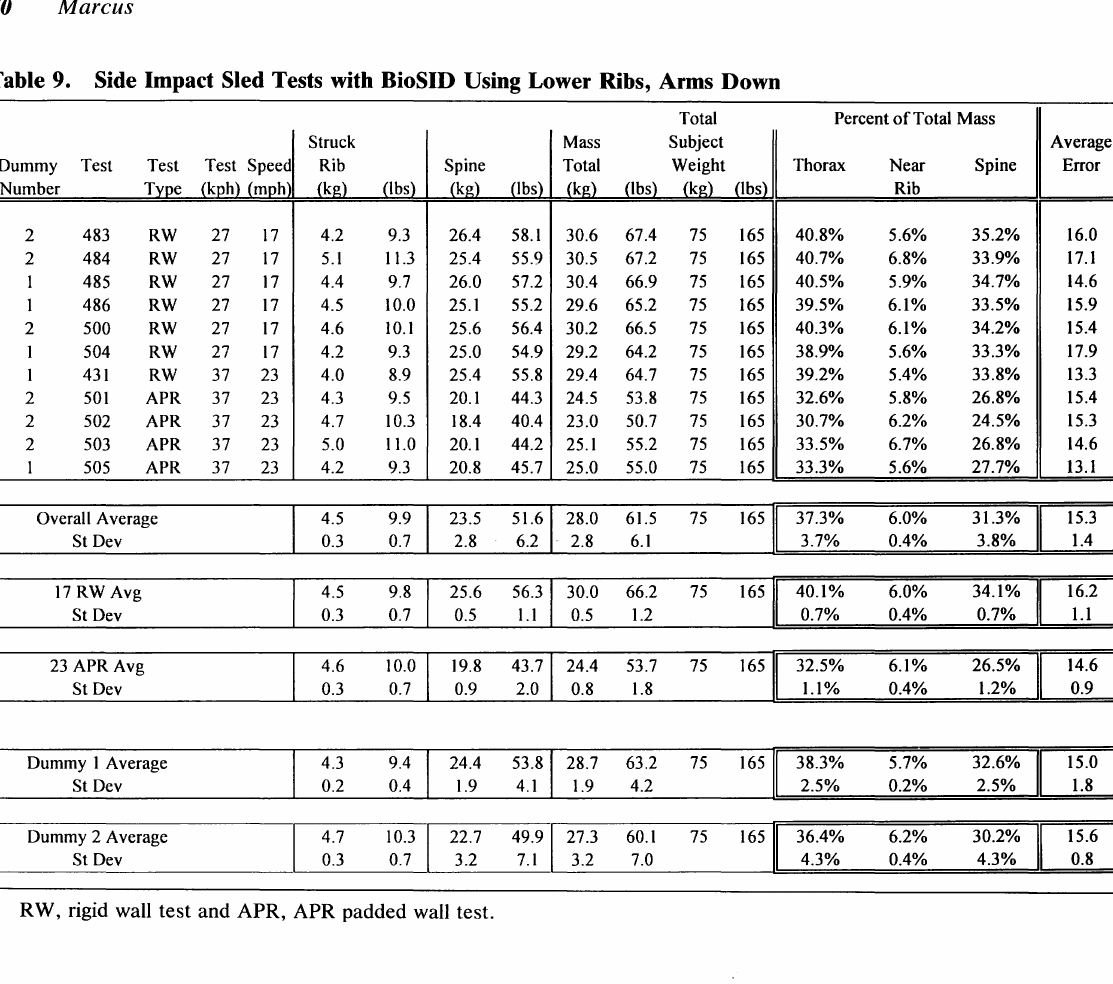
Table 9. Side Impact Sled Tests with BioSID Using Lower Ribs, Arms Down Struck Dummy Test